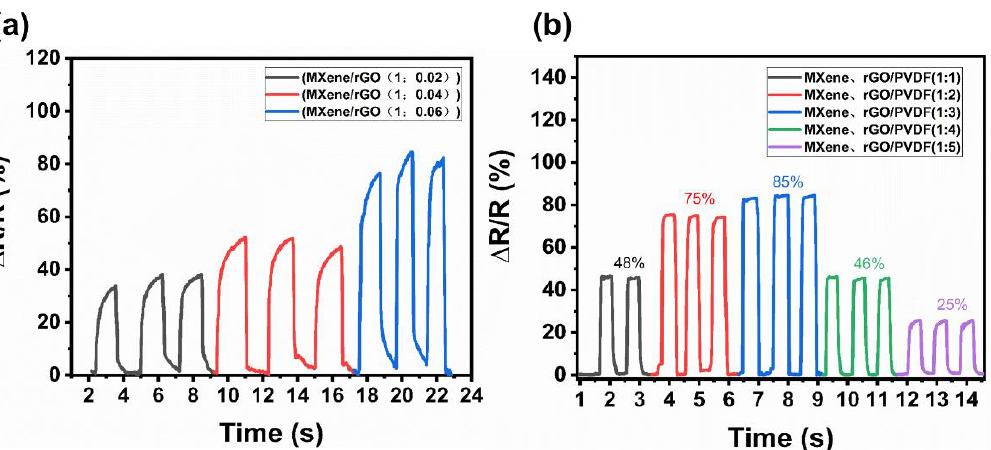
Figure 4. ( a ) Resistance change rates of the MXene/rGO nanocomposite thin films with different ratios (1:0.02, 1:0.04, and 1:0.06, respectively). ( b ) Resistance change rates of MXene-rGO/PVDF